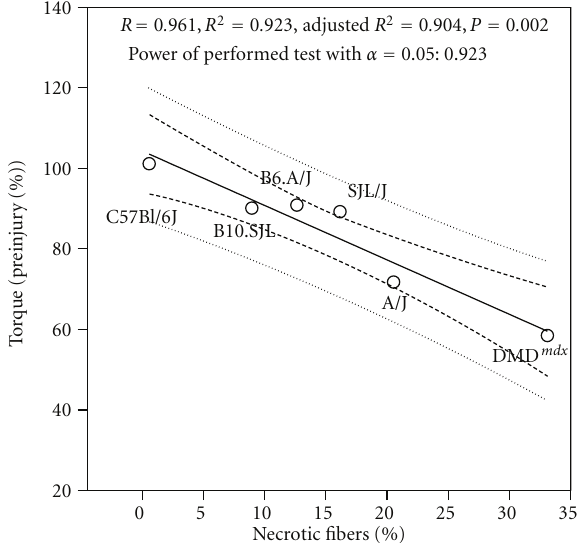
Figure 7: D3 contractile torque regressed on necrosis. A regression analysis of necrosis as the independent variable and D3 torque as the dependent variable showed a good linear fit, suggesting that the extent of necrosis is a reliable negative predictor of functional recovery at D3. The dashed and dotted lines represent the 95% confidence and prediction intervals, respectively.